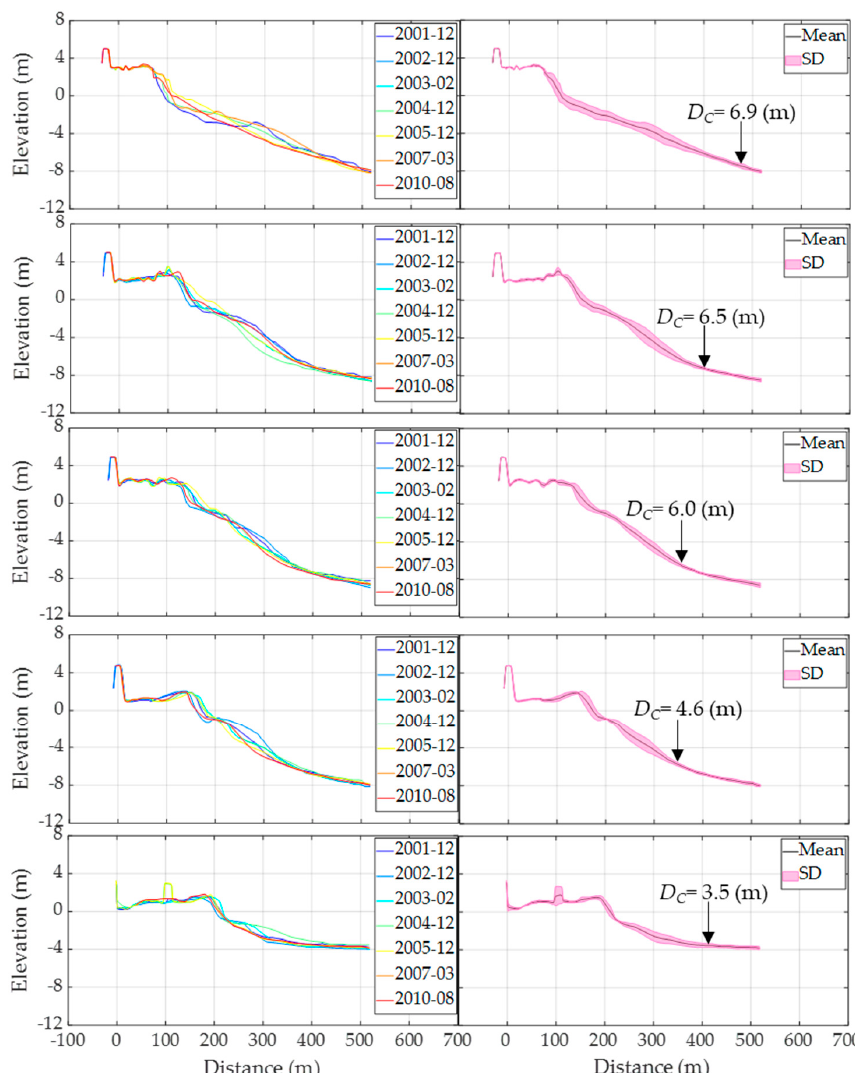
Figure 9. Selected beach profiles and determination of depth of closure. (Datum: Tokyo Peil).